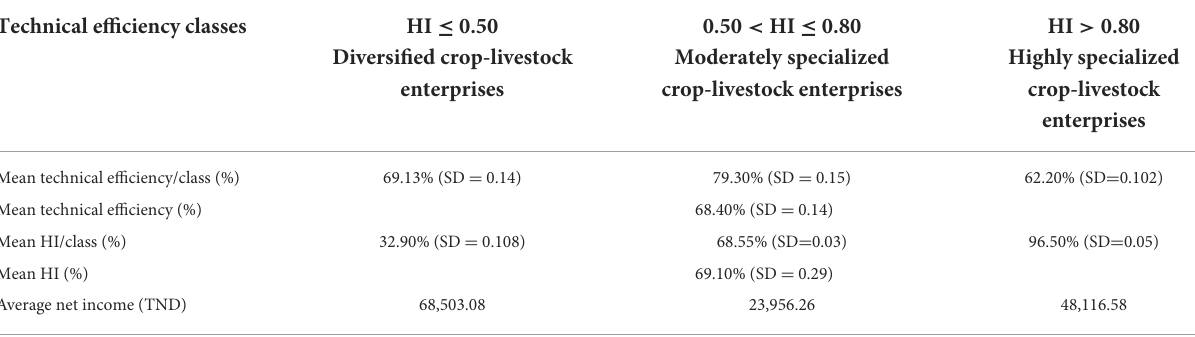
TABLE 4 Frequency distribution of technical efficiency according to HI clusters for CA adopter